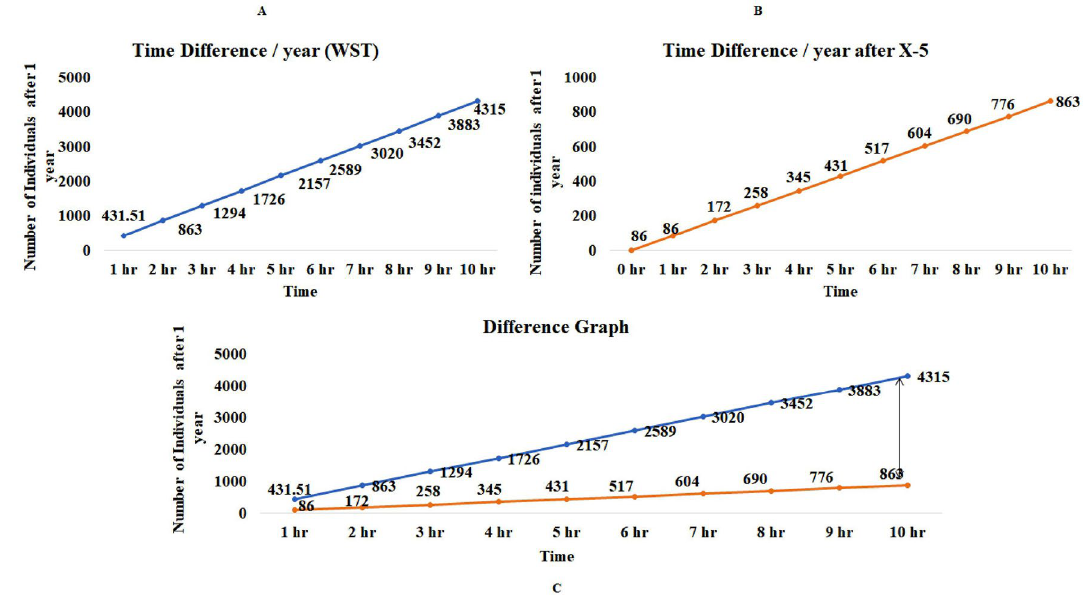
Figure 4. ( A ) The WST graph depicts the number of available samples before introduction of variable, as we increase the time of sample collection, the chances of getting individuals will also increase and the probability of getting samples will increase. ( B ) Graphs depict the availability of samples per hospital after introduction of variable and time adjustment: if we increasing the time the chance of getting individuals also increased. ( C ) Difference graph shows how the introduction of variable minimize the bias ( WST without